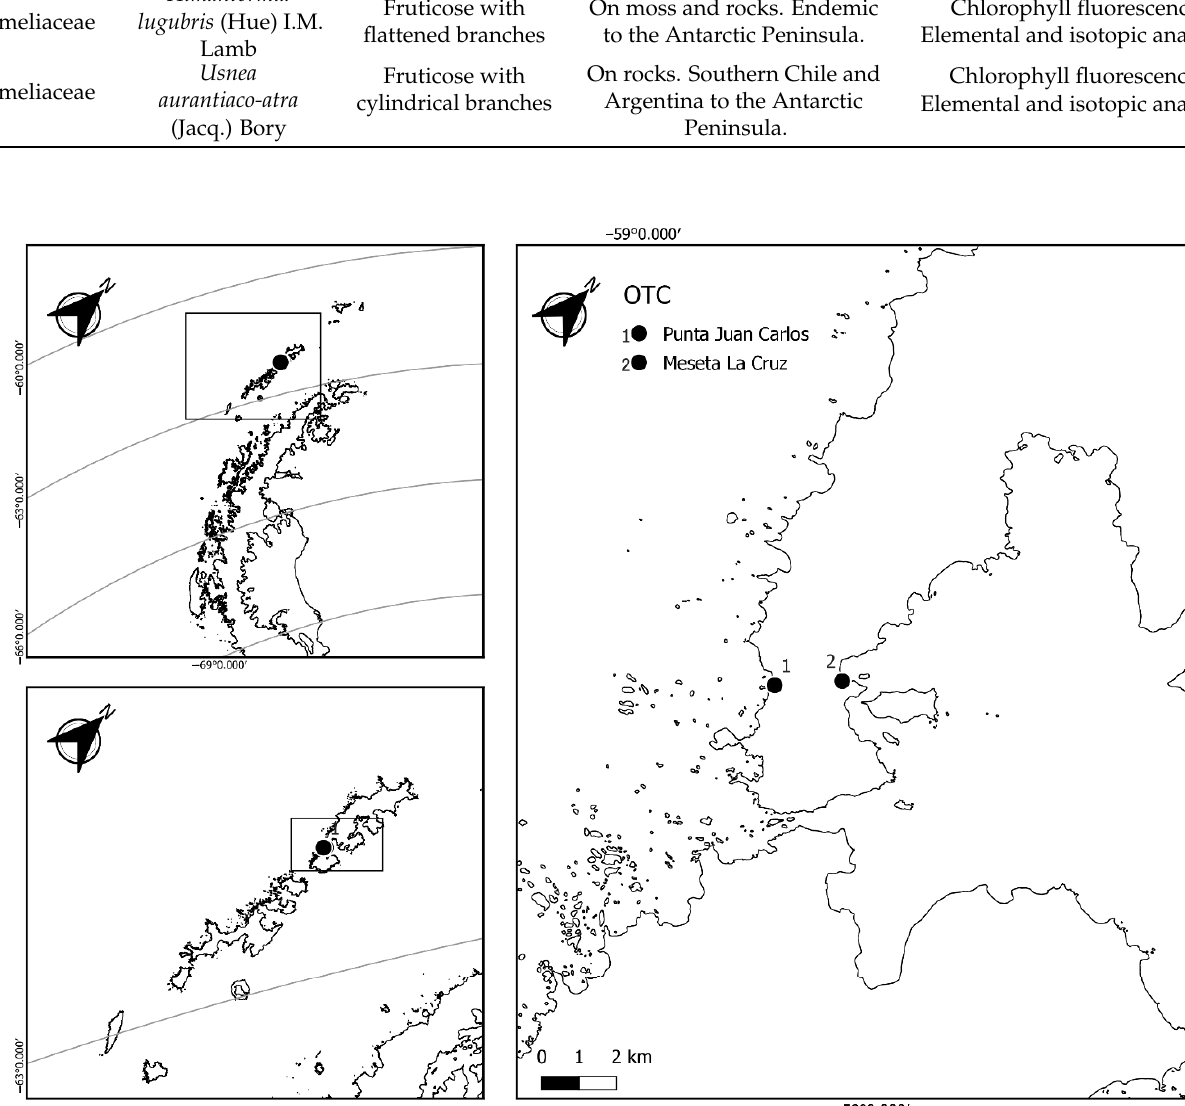
Figure 7. Map of King George Island, South Shetland Islands, west coast of the Antarctic Peninsula. The right panel shows the location of passive warming chambers on the Fildes Peninsula. 1. Punta Juan Carlos; 2. Mesta La Cruz. Map made according to the dataset of Gerrish et al. [59], accessed on